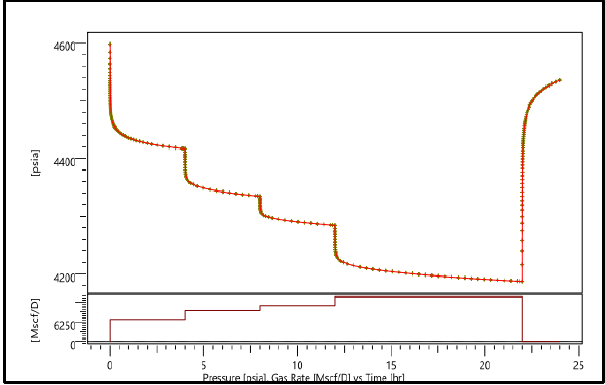
Fig. 9. Plot representing Pressure, Production rate vs